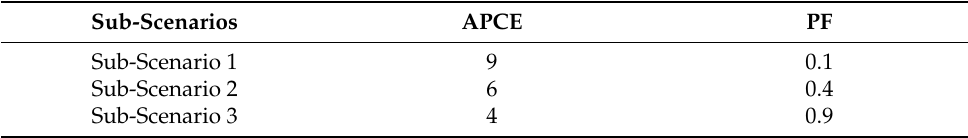
Table 5. Enterprise performance scenario setting.